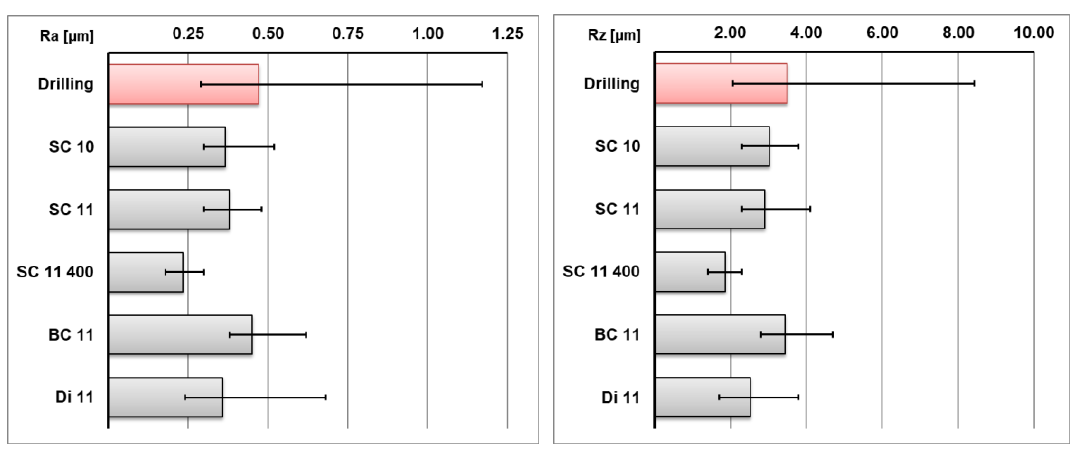
Figure 3. Ra [µm] and Rz [µm] roughness values after drilling and after finishing Ti6Al4V. Figure 3. Ra [ µ m] and Rz [ µ m] roughness values after drilling and after finishing Ti6Al4V.